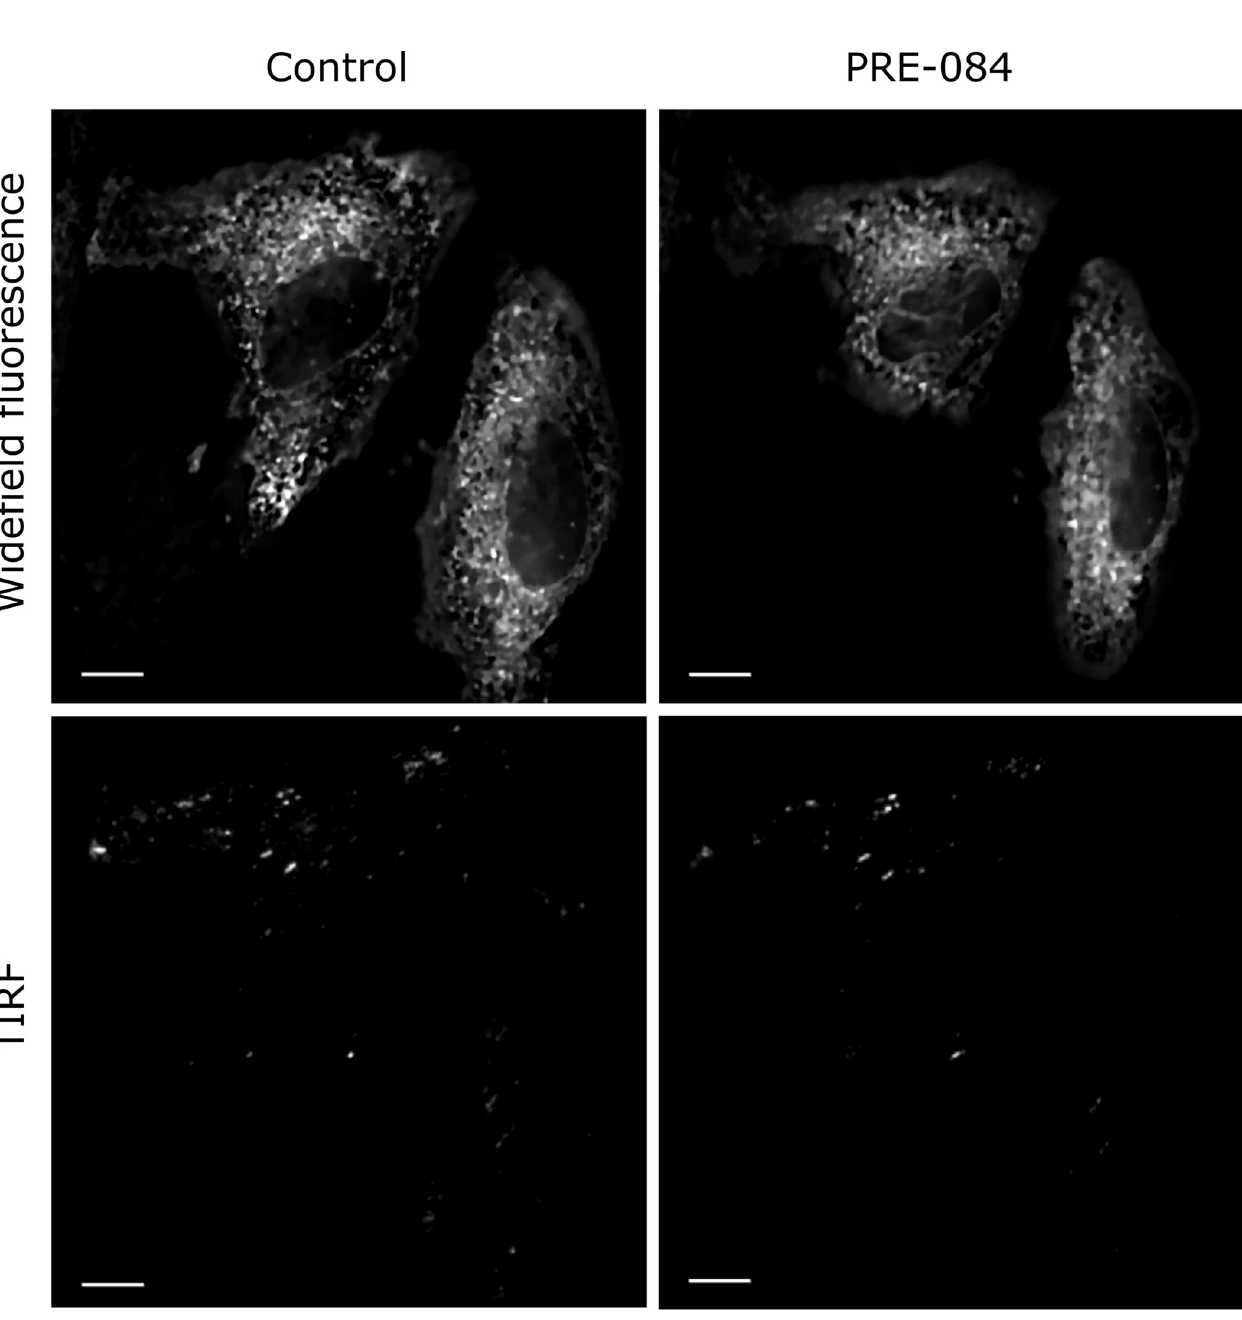
Fig 2. Widefield fluorescence and TIRF images of Sig1R-YFP in SK-OV-3 cells after Sig1R activation with PRE-084. SK-OV-3 cells in 8-well glass-bottom imaging chambers were transfected with recombinant BacMam baculoviruses of Sig1R-YFP (MOI = 3) 24 h before imaging. The imaging was performed on the microscope stage (heated at 37˚C and supplemented with 5% CO 2 ) using 60 × oil (NA 1.49) objective lenses (Olympus Corp., Tokyo, Japan) and 515 nm laser for excitation. Images were taken before (Control) and 30 min after the application of the Sig1R agonist PRE-084 (10 μ m, final concentration). Scale bar = 10 μ